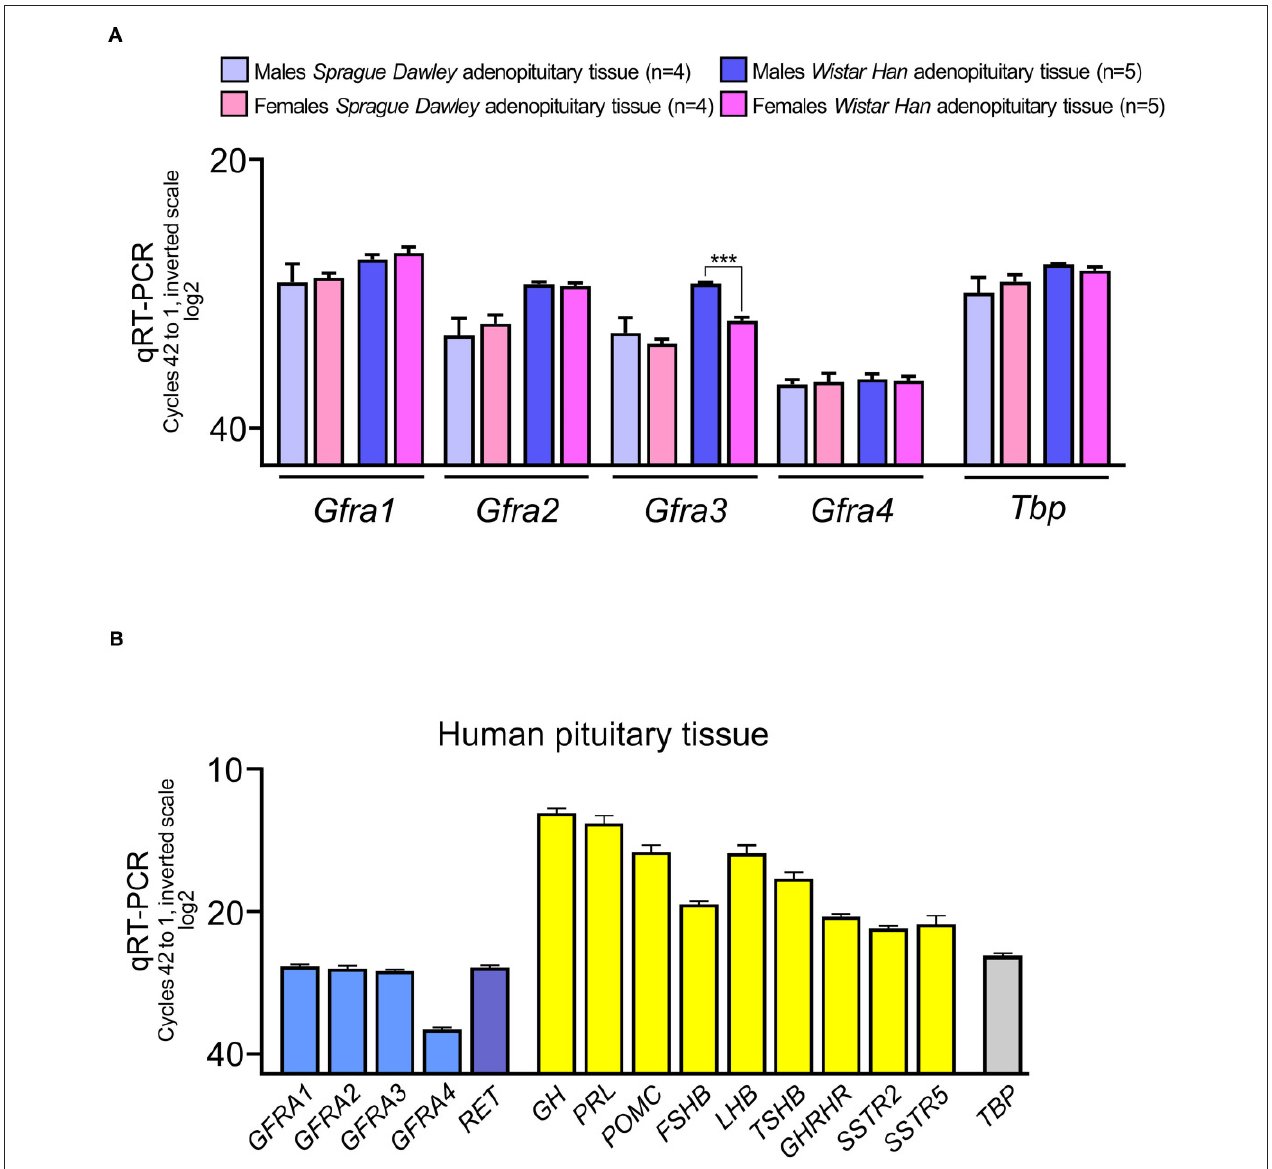
FIGURE 1 | RNA expression of the GFRA co-receptors of RET in the adenopituitary. For comparative purposes among different genes, expression is shown in cycles of the qRT-PCR compared to the housekeeping control gene, Tbp (in rat pituitary) or TBP (in human pituitary). The total number of cycles is 40. Less cycles required for amplification, closer to 20 cycles, higher expression since the scale is log2. (A) The four co-receptors are expressed in male and female adenopituitary from the two most common strains used in biomedical research, Sprague-Dawley, and Wistar. The most abundant co-receptor is Gfra1 and the least expressed is Gfra4 . Female Wistar adenopituitary express significantly less Gfra3 than males. (B) Expression of GFRA co-receptors and RET in human normal pituitary, pooled from men, and women. For comparative purposes hormones and receptors for hypothalamic factors were also measured. As in rat pituitary, GFRA4 is the less abundant in human